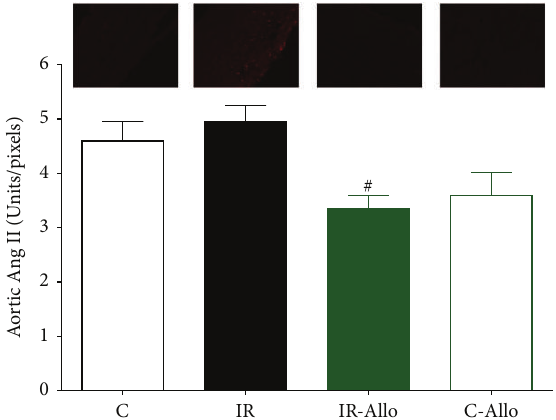
Figure 5: The effect of allopurinol (Allo) treatment on insulin resistance (IR) induced 4HNE changes, measured in Units/pixels. Values are expressed as the mean ± SEM; 𝑁 = 6 – 8 animals; ∗ 𝑃 < 0.05 , compared with the corresponding control group values; ## 𝑃 < 0.01 compared with thecorresponding IRgroup values, by One-Way ANOVA and Newman-Keuls post hoc test.